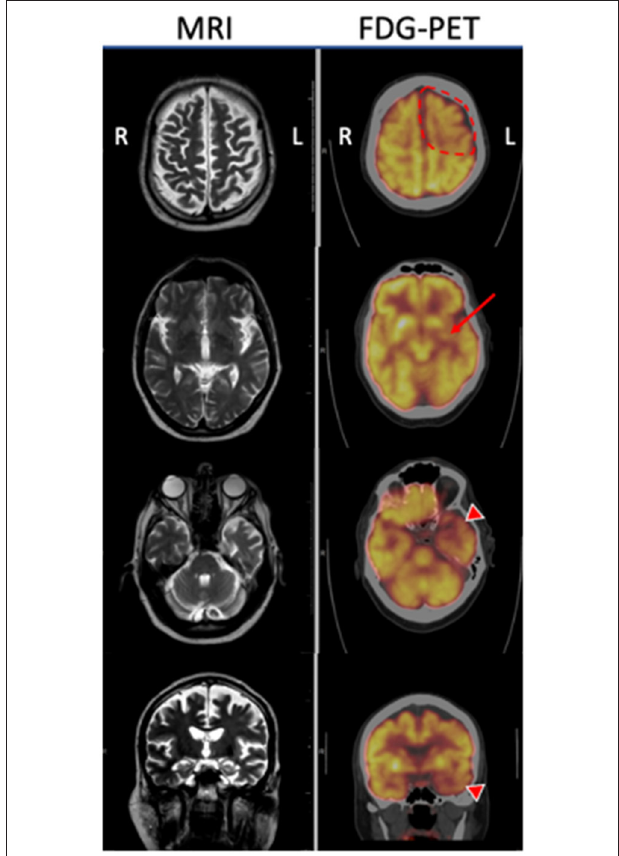
FIGURE 1 | MRI T2 sequences and corresponding FDG-PET imaging of the proband at three axial levels and a coronal image through the hippocampi. MRI demonstrates generalized cortical atrophy of the left hemisphere, especially evident within the left anterior temporal lobe. FDG-PET reveals hypometabolism of left frontal lobe (dotted line) that was more prominent than the right, in addition to the left putamen (arrow), and left temporal lobe (arrowheads) compared with the corresponding regions on the